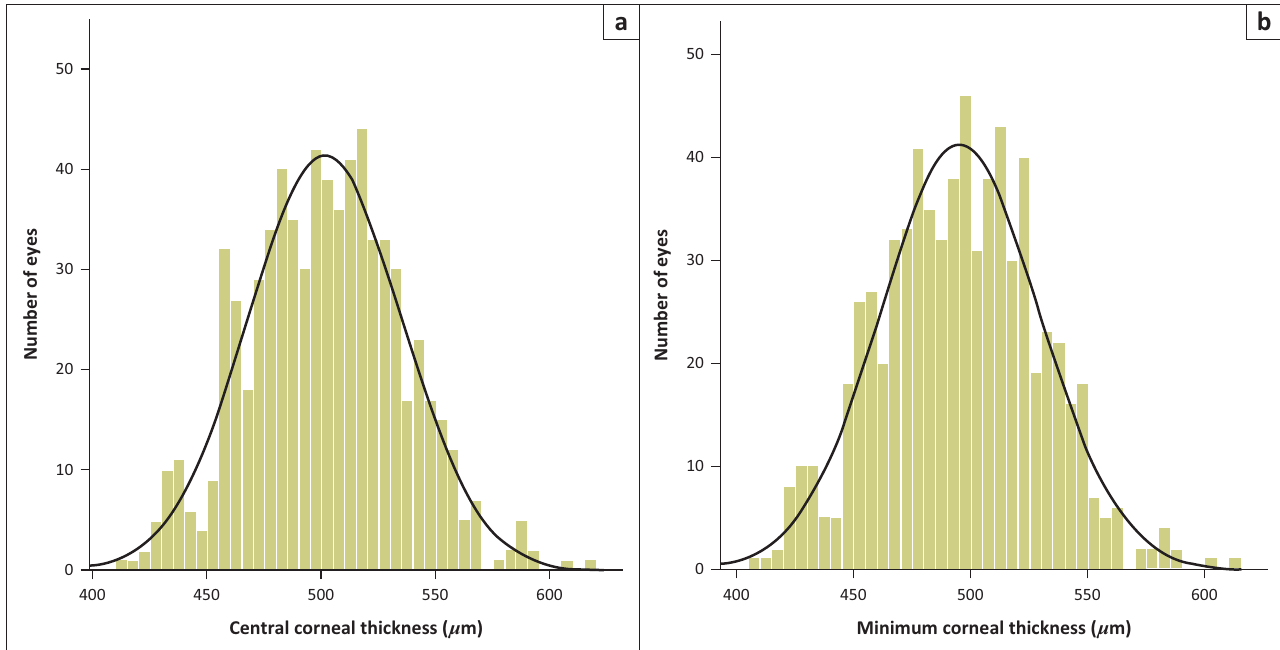
FIGURE 2: Distribution of central corneal thickness (a) and minimum corneal thickness (b) ( µ m) in the right eyes of young adult participants ( N = 700), aged 17–30 years.